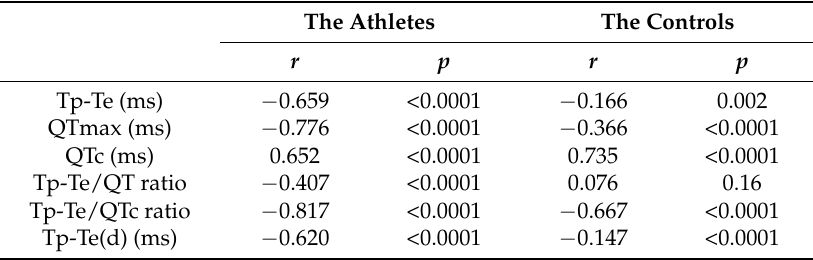
Table 4. Pearson correlation analysis between HR and some electrocardiographic repolarization measurements in the athletes and the controls. The